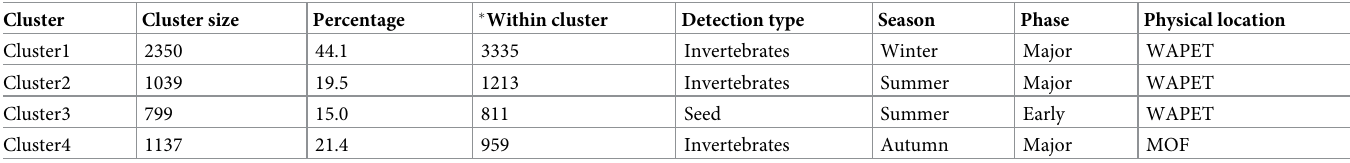
Table 7. Summary statistics using categorical variables only for detection data from Barrow Island between 2009 and